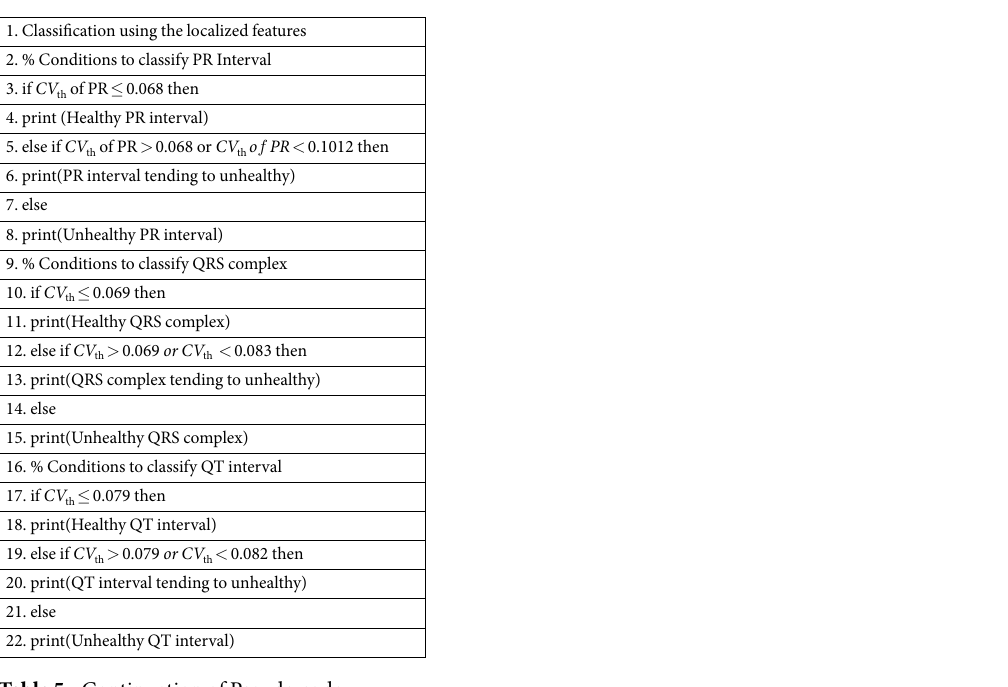
Table 5. Continuation of Pseudo code.